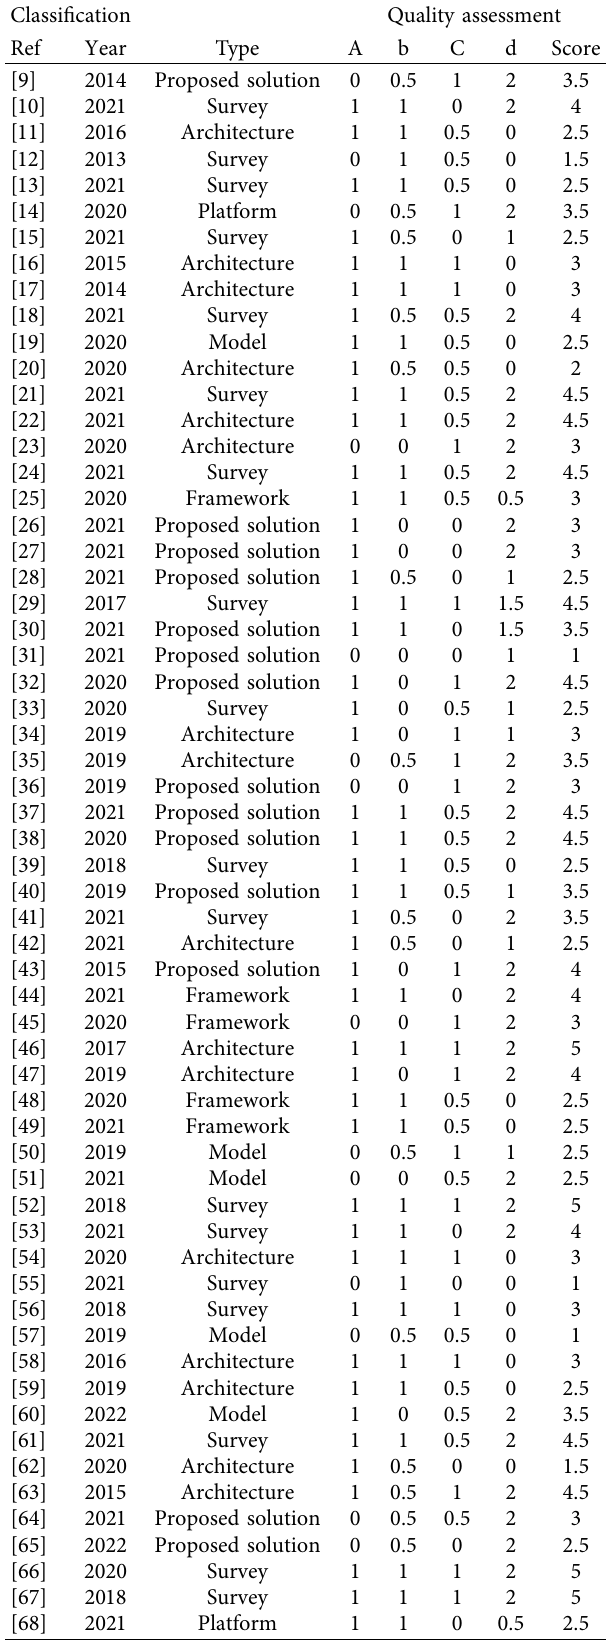
Table 1: Quality assessment